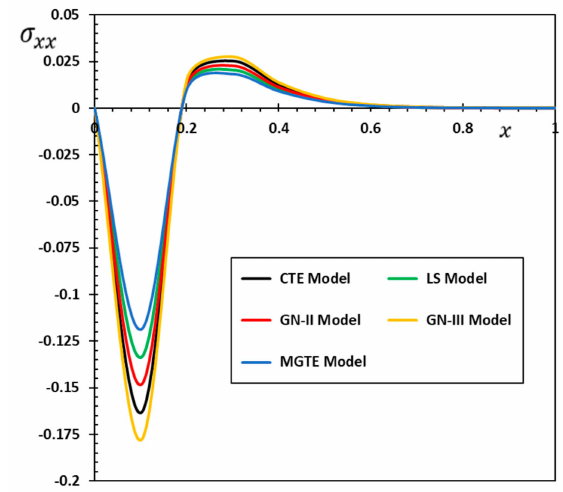
Figure 10. The axial stress σ xx for various thermoelastic